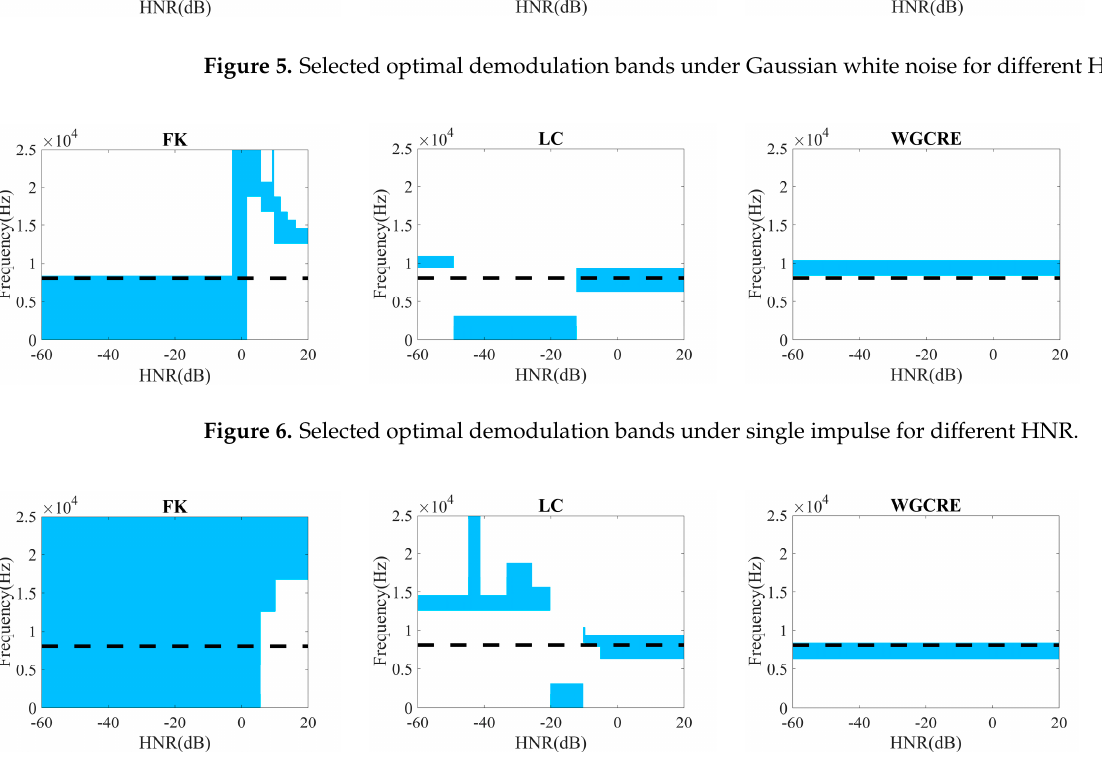
Figure 8. Selected optimal demodulation bands under smooth CS2 noise for different HNR.